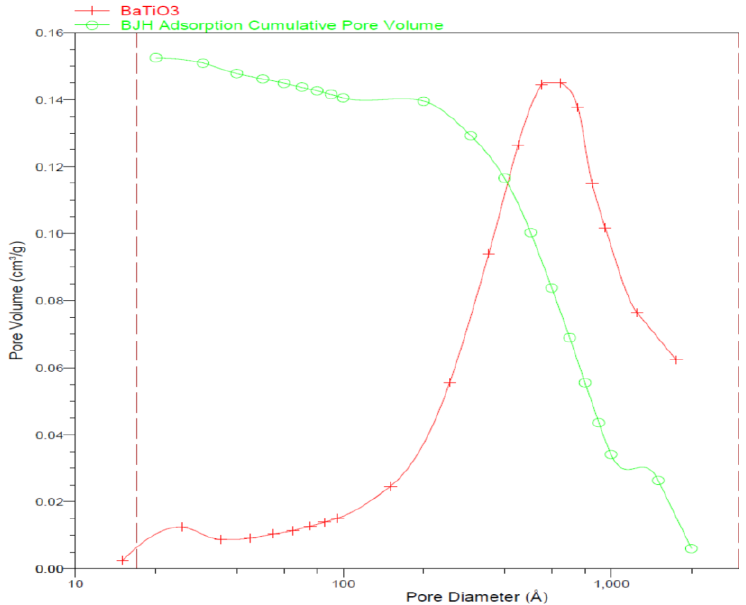
Figure 3. Pore volume of tested BaTiO 3 as a function of pore diameter.